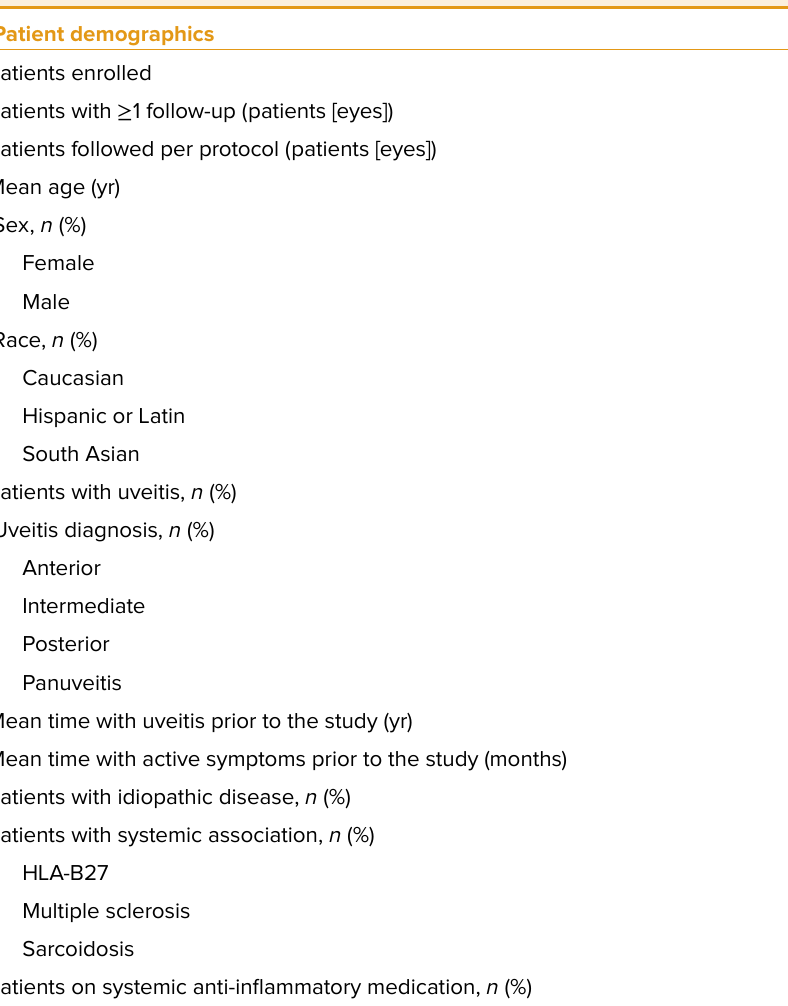
Table 1. Demographics – characteristics and baseline details